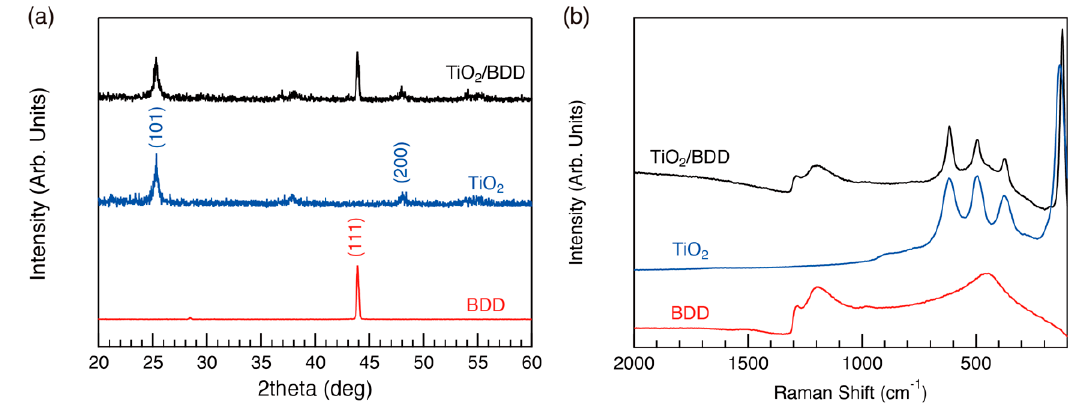
Figure 2. ( a ) Wide-angle X-ray diffraction (WAXD) and ( b ) Raman spectrum of mesoporous TiO 2 /BDD. As a reference, spectra of TiO 2 (anatase) and BDD are also included.